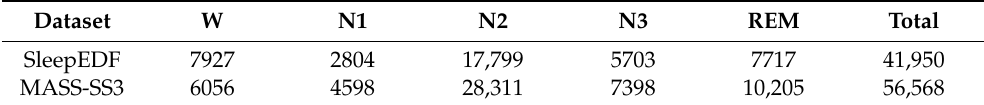
Table 1. The number of samples of the two datasets involved in our work.